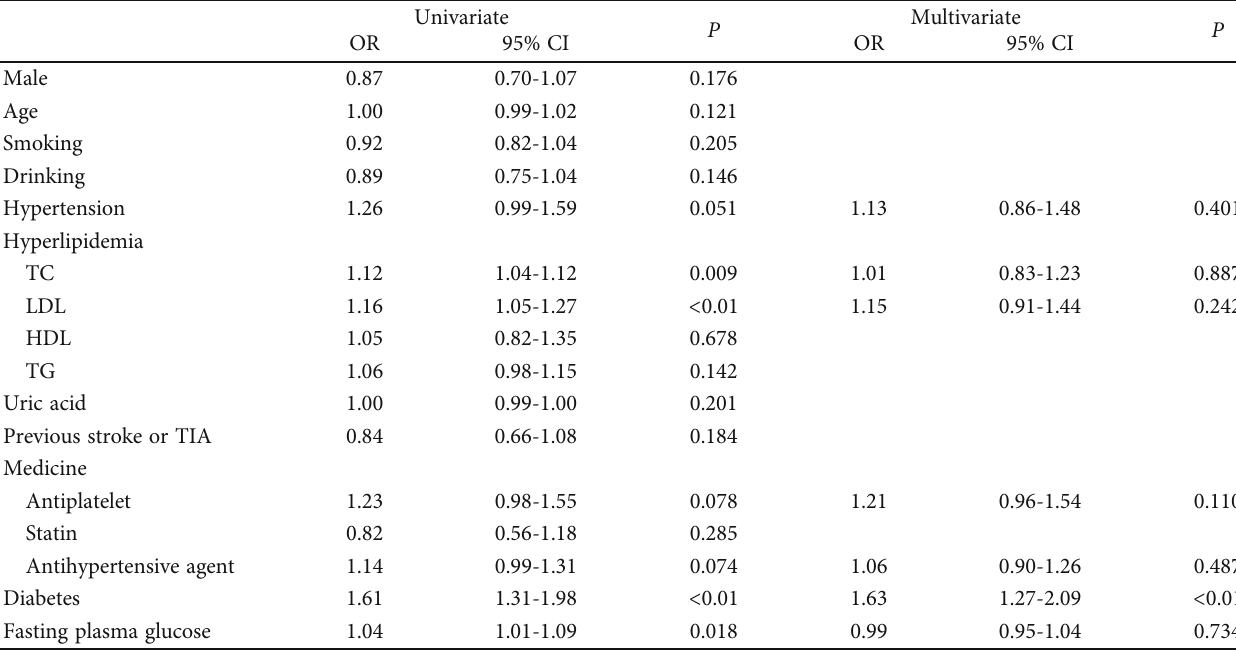
Table 2: Multivariate logistic regression of pontine